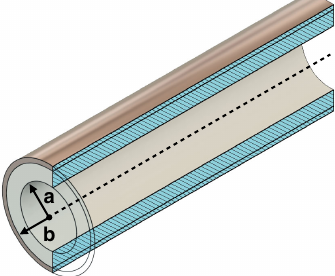
FIG. 1. Schematic of a cylindrical dielectric-lined waveguide. The lining with dielectric constant ϵ r has an inner radius a and an outer radius b . It is coated with a thin metallic layer on the outside.